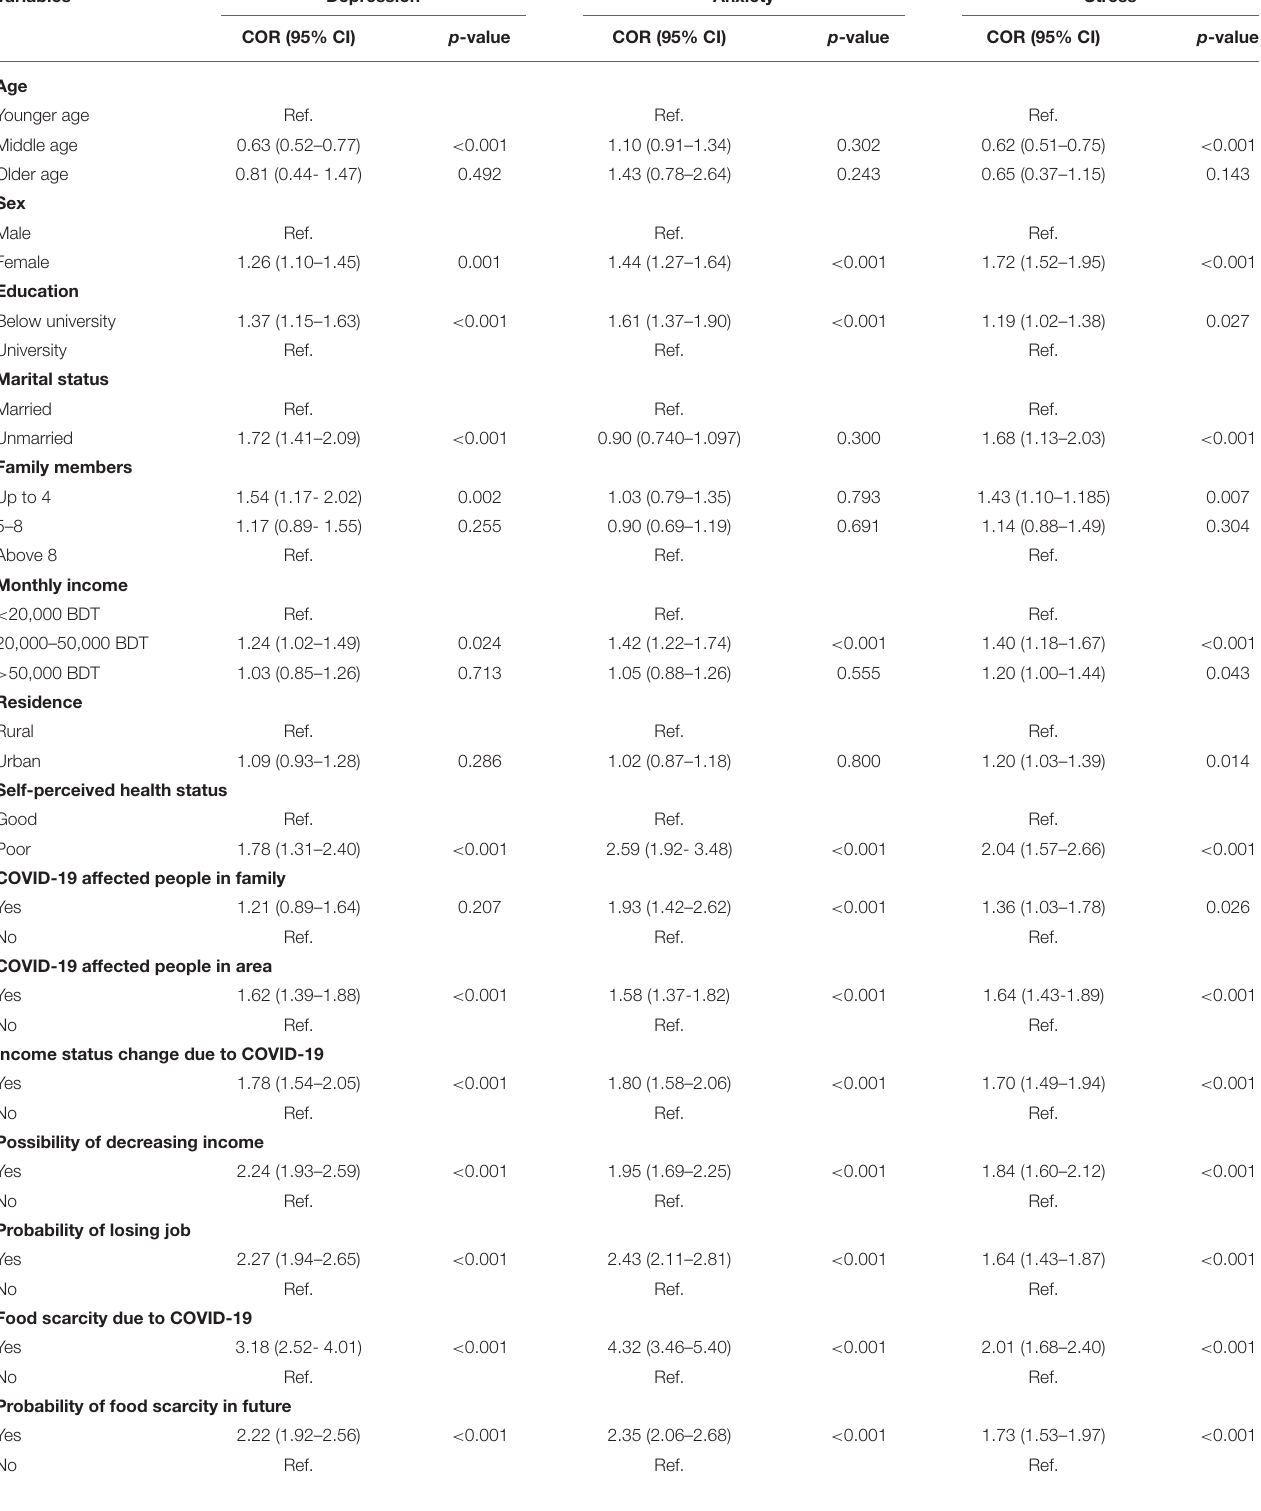
TABLE 2 | Binary logistic regression analysis by depression, anxiety, and stress.